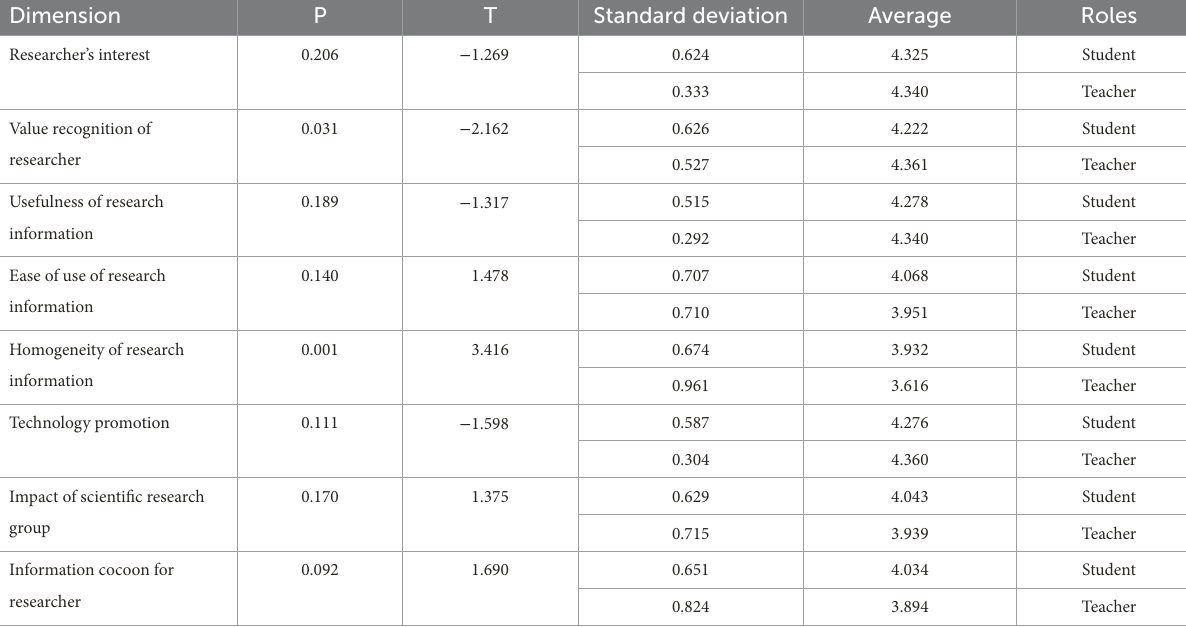
TABLE 5 Differences in dimensions among researchers with different roles. Dimension P T Standard